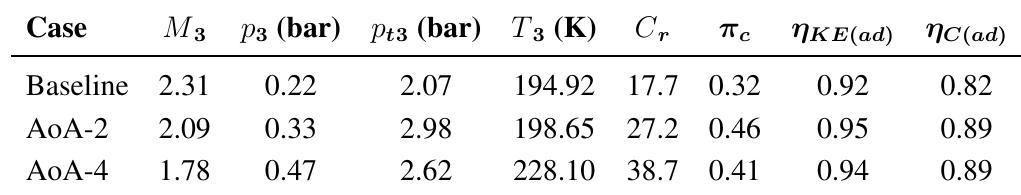
Table 2. The isolator exit flow properties and its associated performance indicators for different